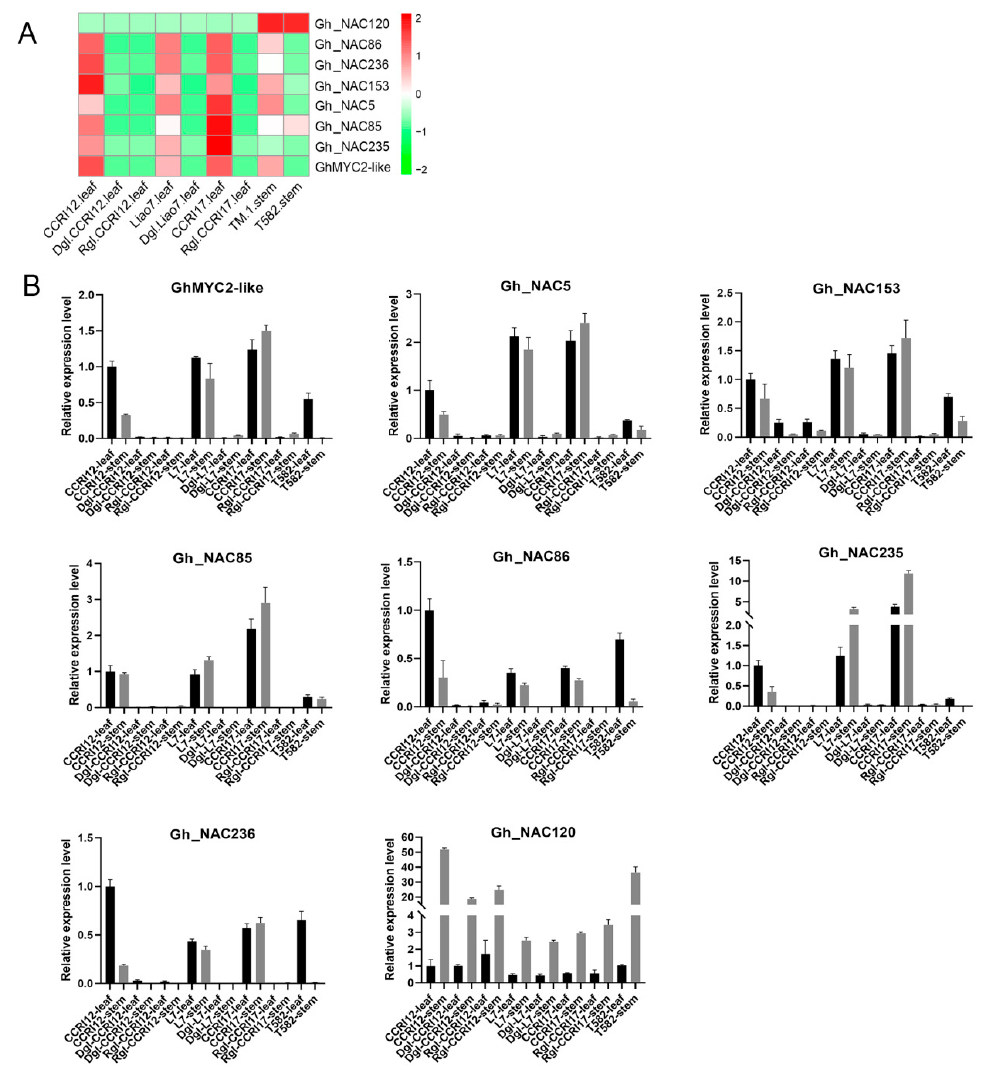
Figure 5. Expression analysis of GhMYC2-like and 7 NAC genes in glanded and glandless cotton (reference gene: actin). ( A ) Relative expression levels of GhMYC2-like and 7 NAC genes in glanded and glandless cotton. ( B ) QRT-PCR analysis of GhMYC2-like and 7 NAC genes in glanded and glandless cotton. CCRI: China Cotton Research Institute, Dgl: dominant glandless, Rgl: recessive glandless, L7: Liaomian7.